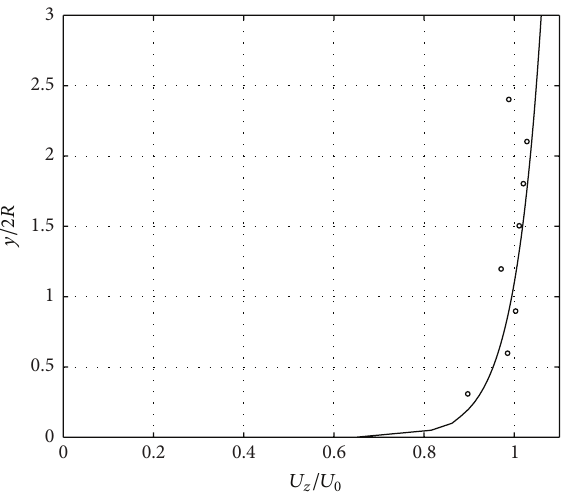
Figure 1: Normalized velocity at the inlet of this study (solid line) and experimental data (∘)